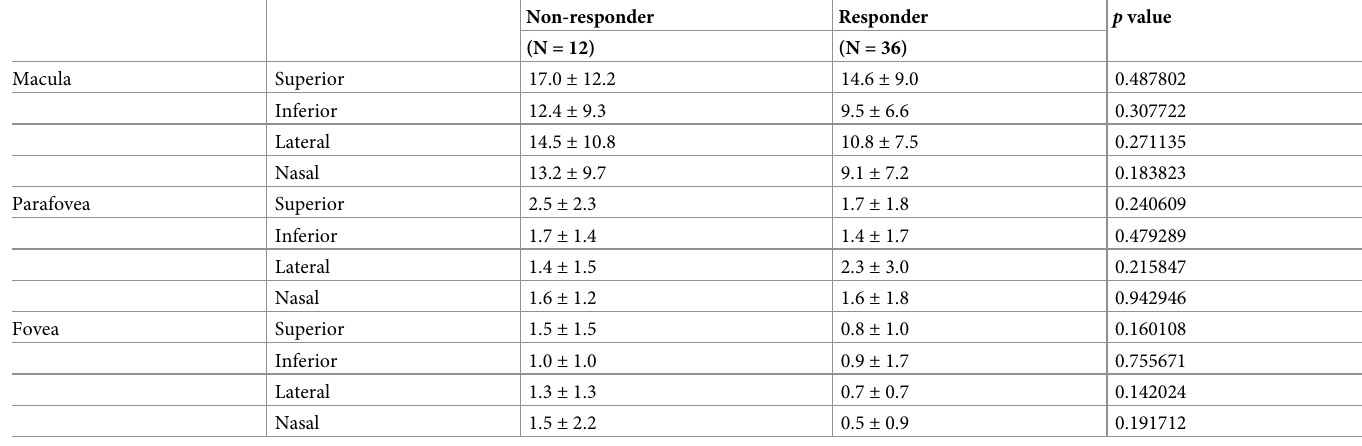
Table 3. Detected MA by